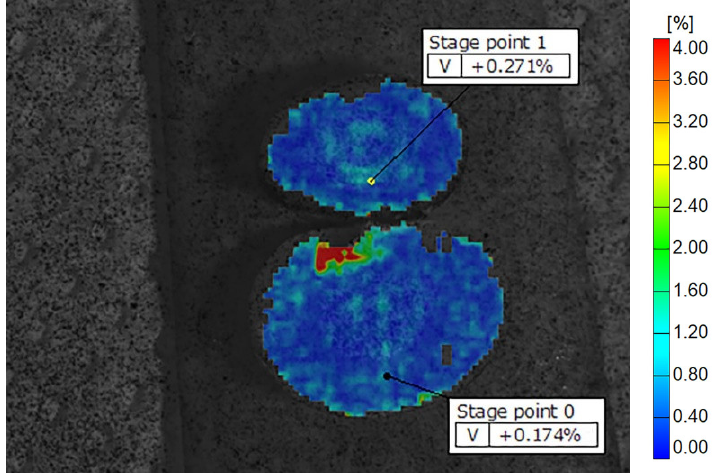
Figure 5. Display of Well-Root PT deformation fields across the samples on dentine discs, showing peripheral zones with higher and central zones with lower strain values. The color scale indicates different strain values, with the highest marked in red and orange. Some of the recorded reference points are shown as stage points 0 and 1. Table 1. Nested ANOVA analysis of significant differences between the materials and dentine discs in the central (SS) and peripheral (SO)